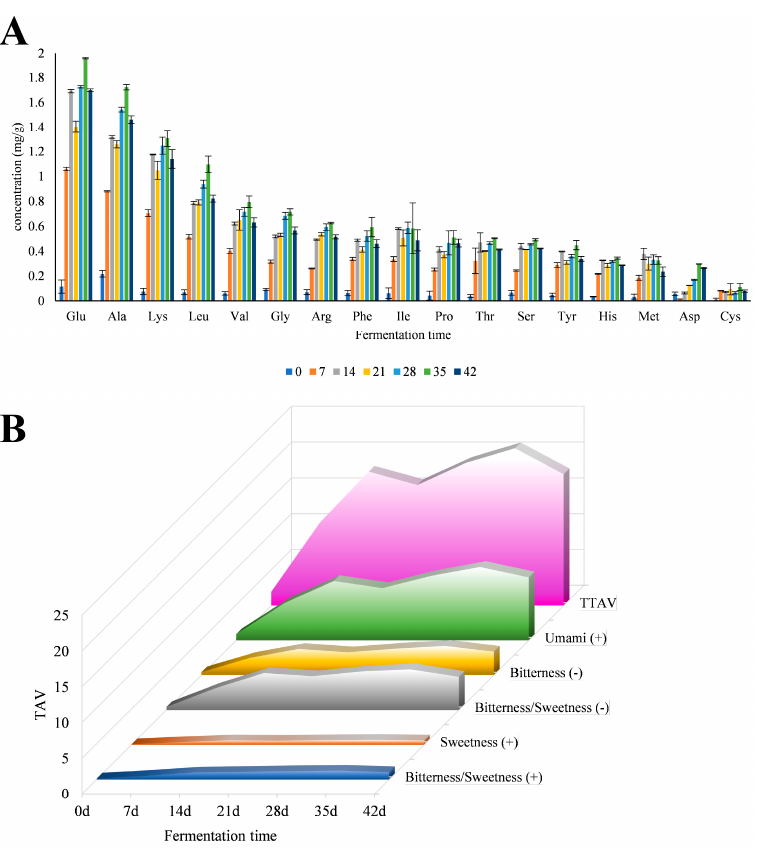
Figure 3. Concentrations of 17 FAA ( A ) and taste activity value (TAV) of various taste amino acids and total TAV (TTAV) at different times ( B ).